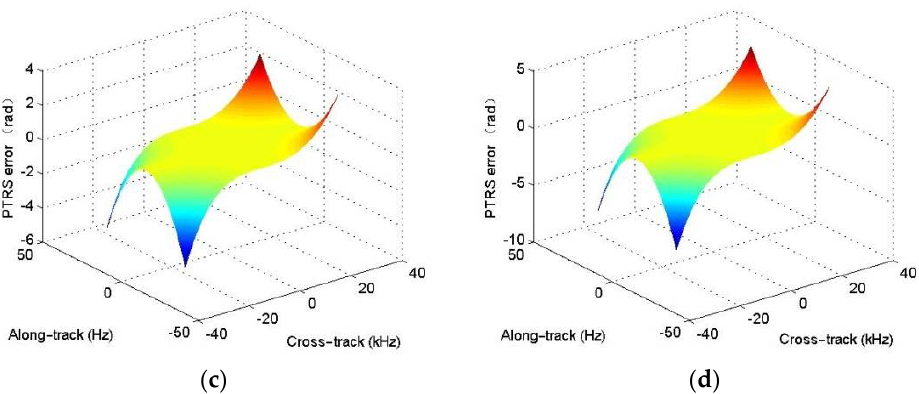
Figure 8. PTRS error for the first transmitter/receiver pair when the system works with a wide- bandwidth. ( a ) r = 40 m; ( b ) r = 110 m; ( c ) r = 180 m; ( d ) r = 250 m.